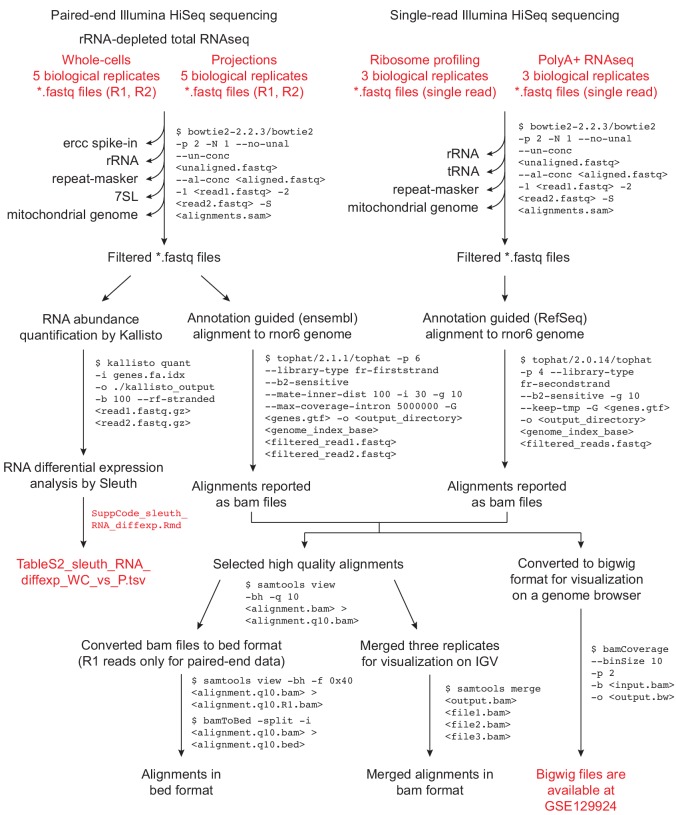
Data analysis workflow.Data analysis workflow for sequence alignments and RNA abundance quantitation. Files provided as supplementary data or available at GSE129924 are in red text.